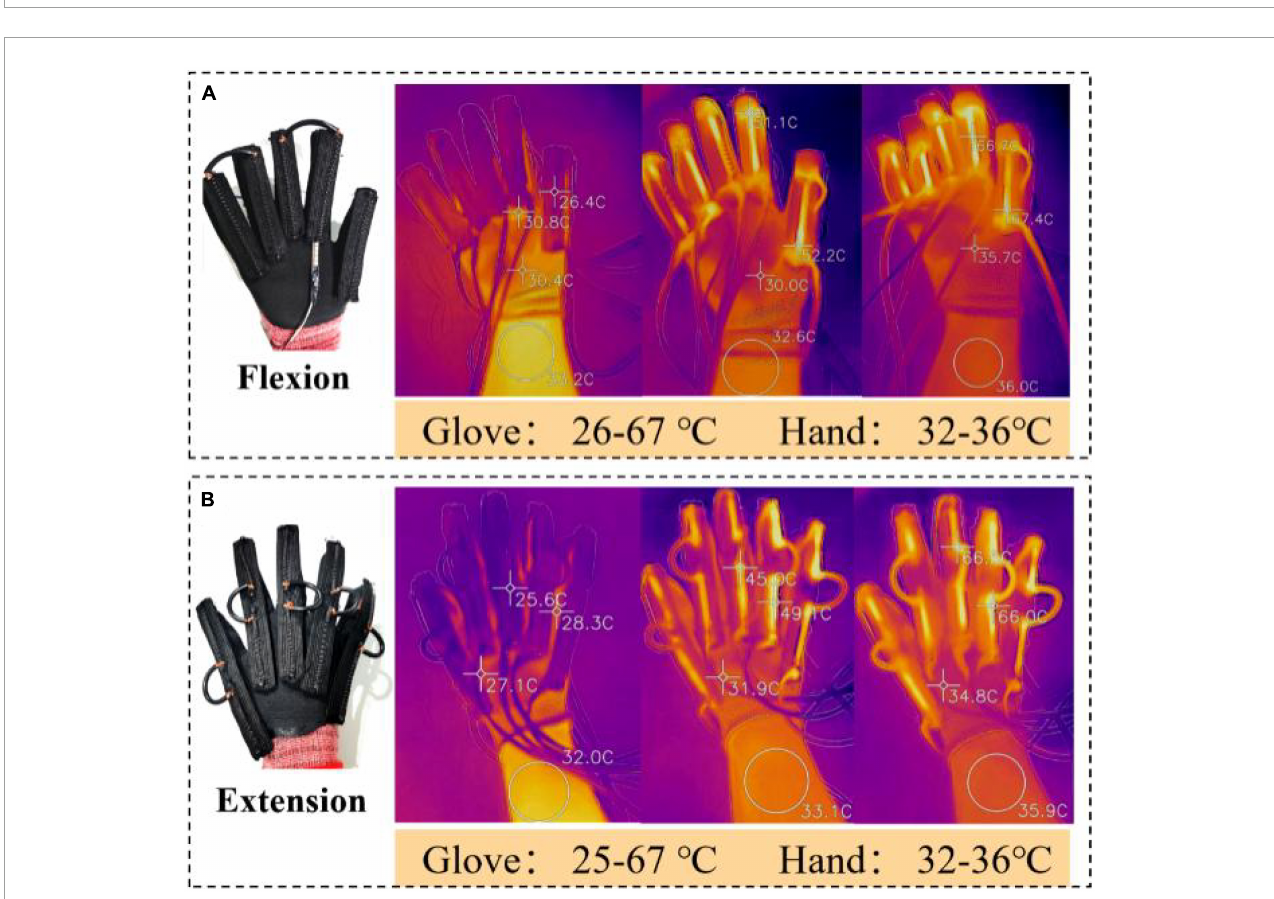
FIGURE12 Temperature measurement experiment. (A) The maximum temperature of the SMA springs and wrist during hand flexion; (B) the maximum temperature of the SMA springs and wrist during hand extension.